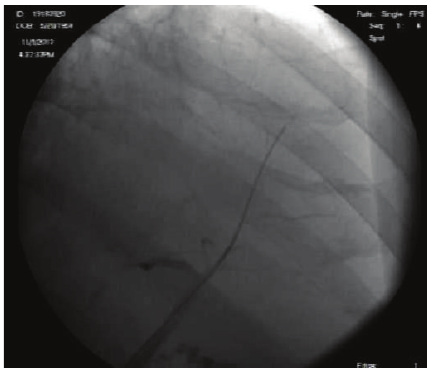
Figure 4: ERCP showing pruning of the biliary tree.